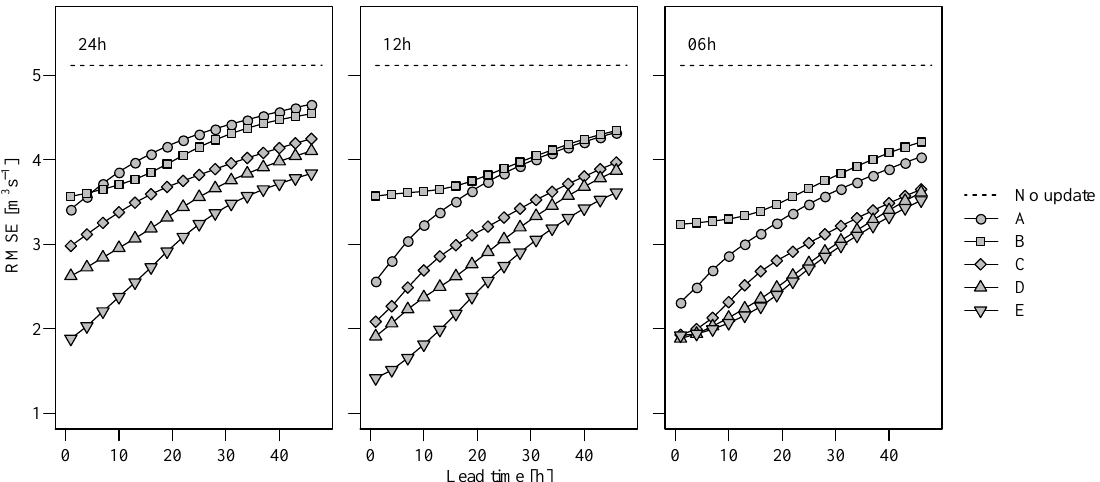
Fig. 5. Synthetic experiment, simulation period from 15 August 2002 to 15 January 2003. Root-mean-square error at Tabreux for different discharge observation vectors. Forecast issued every 6h. EnKF assimilation was carried out every 24h (left), 12h (centre), 6h